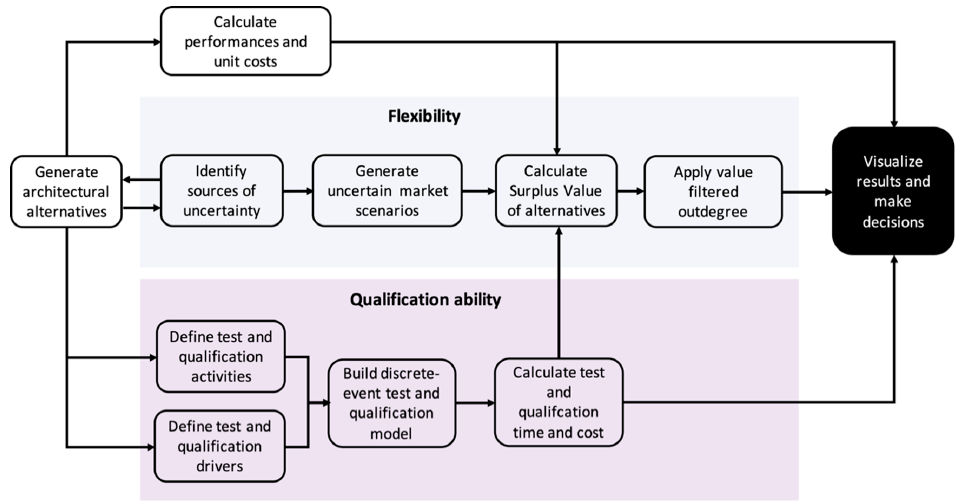
Figure 3. Proposed method to trade flexibility and qualification ability against functional performances and unit costs.